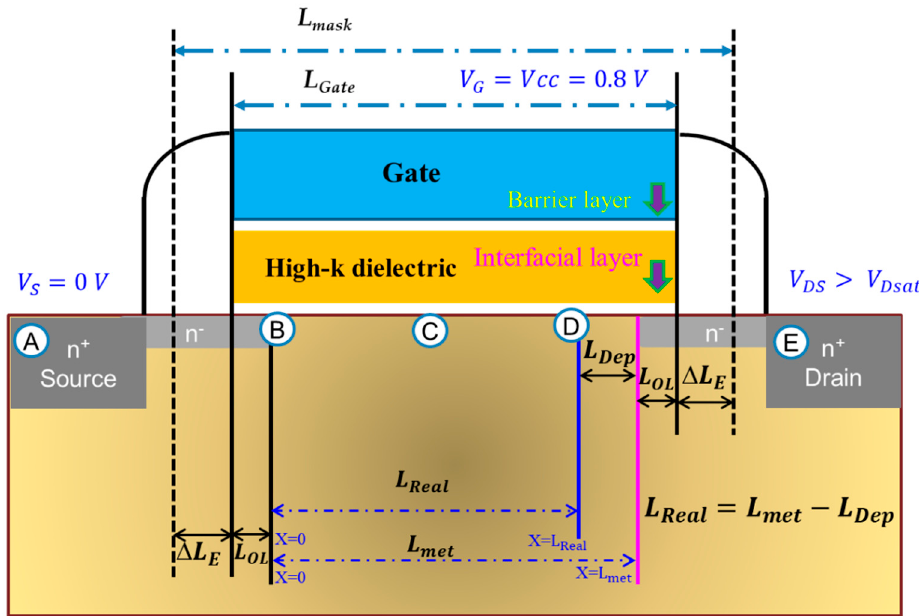
Figure 2. Schematic cross-section diagram of an nMOSFET with the definition of channel lengths.